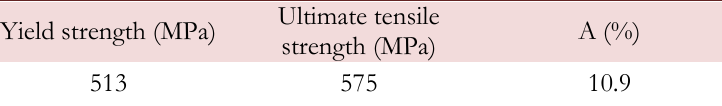
Table 2: Monotonic mechanical tensile properties of 7075 T6 aluminium alloy.